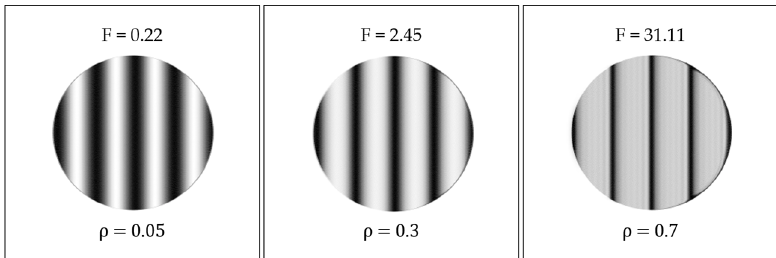
Figure 7. Interferogram with different parameters.